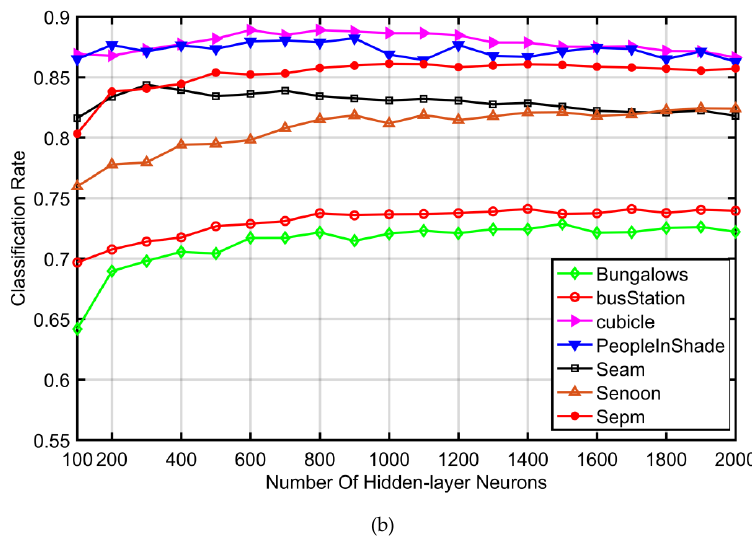
Figure 5. Classification rates of our method with a different number of hidden-layers on two datasets. ( a ) variation tendency on the popular dataset; ( b ) variation tendency on the large dataset.